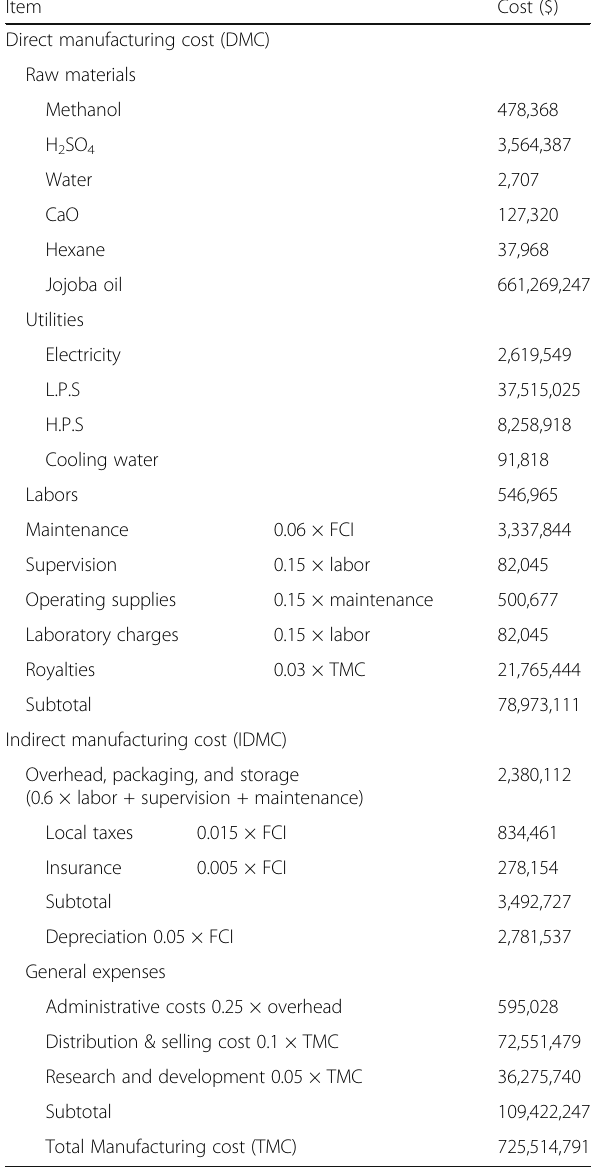
Table 6 Total manufacturing